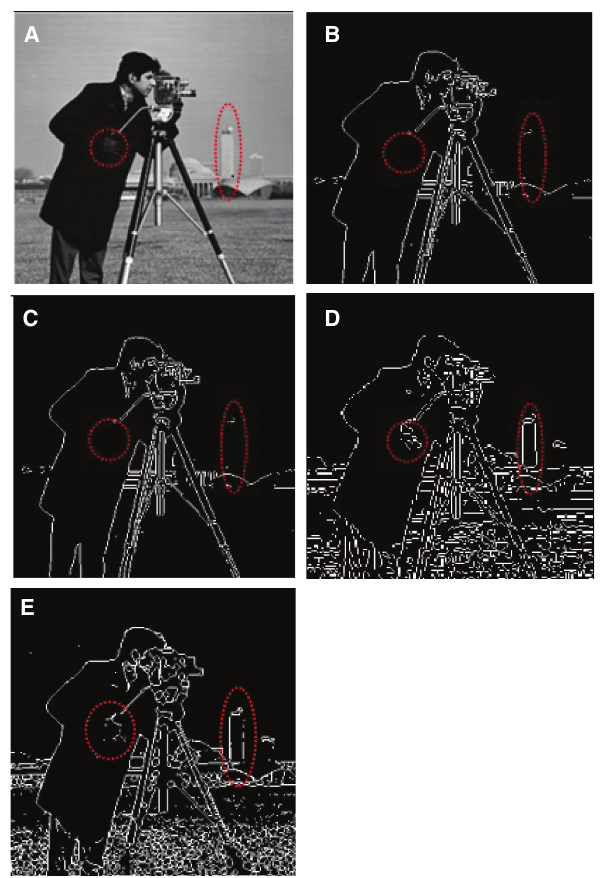
Figure 4. Comparison of the proposed method with traditional edge detection